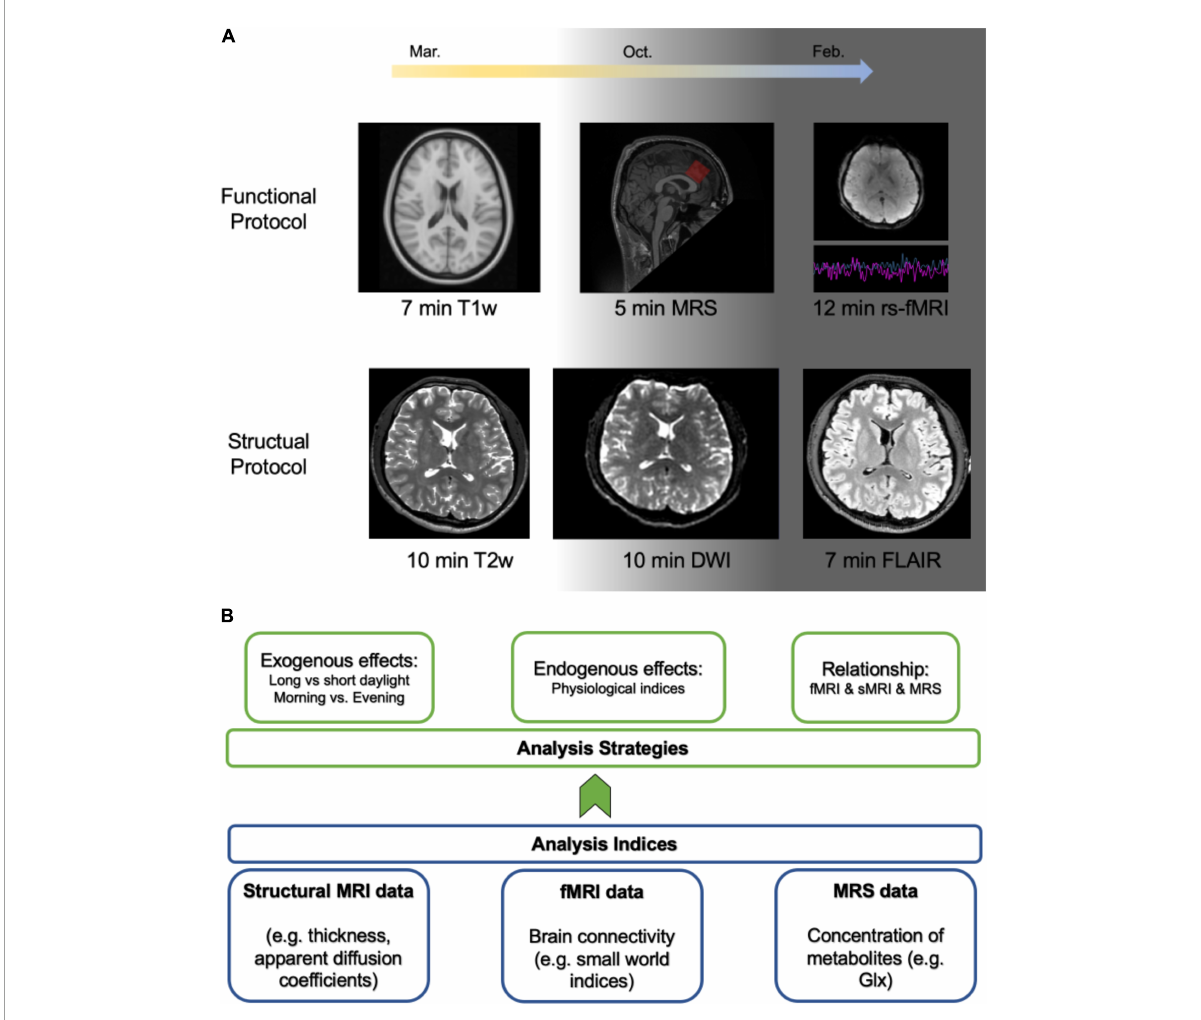
FIGURE1 Skeleton of the project and analysis plan. (A) The project neuroimaging protocols. The background indicates that daylight time will gradually be minimized from spring to winter. The functional protocol was implemented twice a week while the structural protocol was implemented once a month. (B) The illustration of the analysis